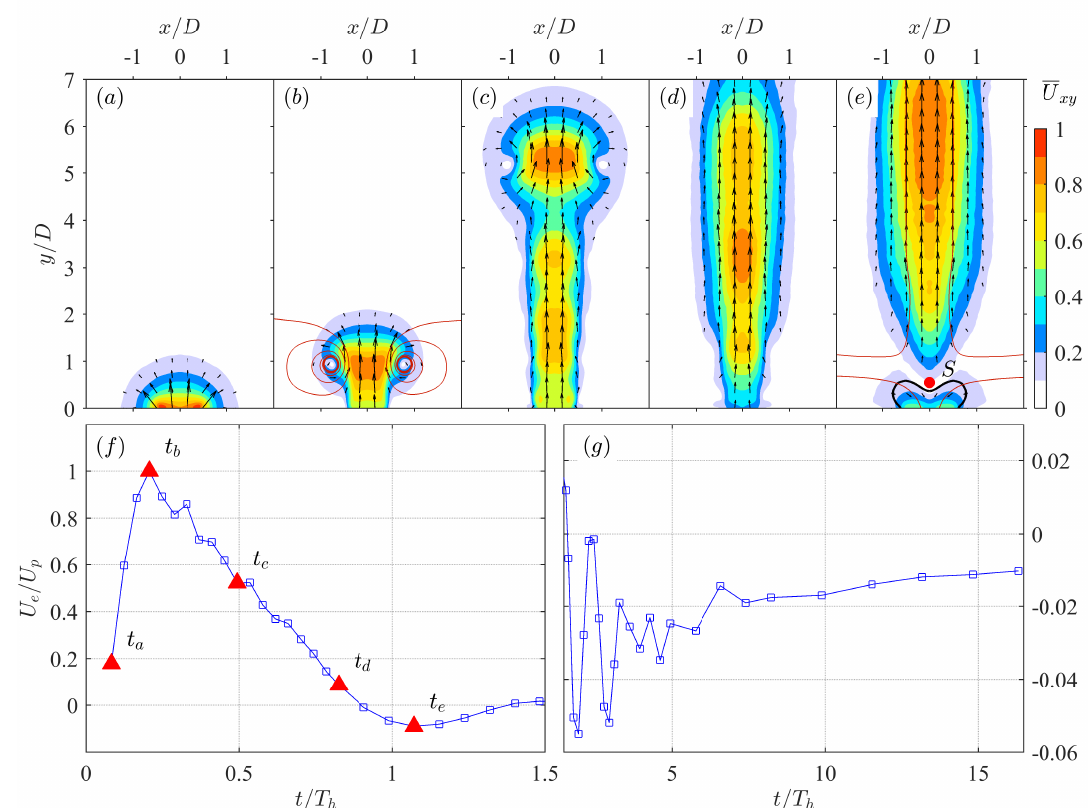
Figure 7. ( a – e ) Phase-averaged evolution of PSJs at (cid:101) = 2.6 and f ∗ = 0.06 (reproduced from the dataset measured by Zong and Kotsonis in [33]). From left to right, the phases displayed are t a = 50 µ s, t b = 125 µ s, t c = 300 µ s, t d = 500 µ s, and t d = 650 µ s. The in-plane velocity ( U xy ) is normalized to an identical range of 0–1 by dividing their respective maxima (20 m/s, 120 m/s, 91 m/s, 38 m/s, 23 m/s). The magnitude and direction of the normalized in-plane velocity ( U xy ) are displayed as contours and vectors, respectively. The thin red lines superimposed on ( b , e ) are streamlines. The thick black line in ( e ) represents the velocity contour line of U x / U p = − 0.01. ( f , g ) Time evolution of the spatially averaged exit velocity ( U e ) in one cycle. The peak exit velocity ( U p = 116 m/s) is used for normalization. Note that different scales are used for the phases before and after t / T h = 1.5. The five phases corresponding to Figure 7a–e are indicated in the exit velocity curve by red